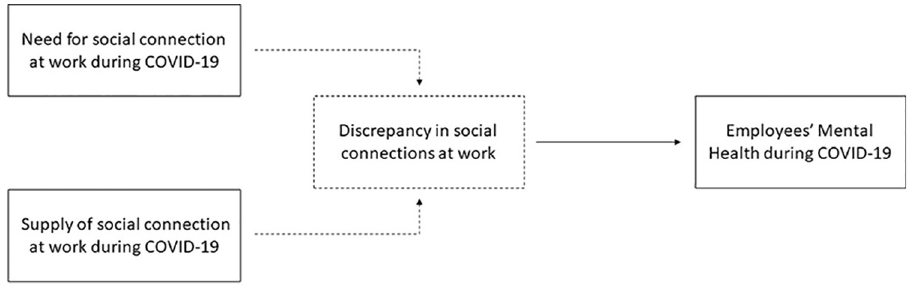
Fig 1. Conceptual framework (Adapted from Bohndick and colleagues